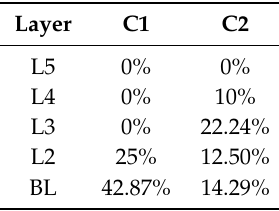
Table 6. Per layer FEC percentage per class for ALD-SC.